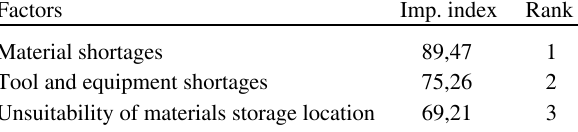
Table 5. Ranking factors under materials/tools group